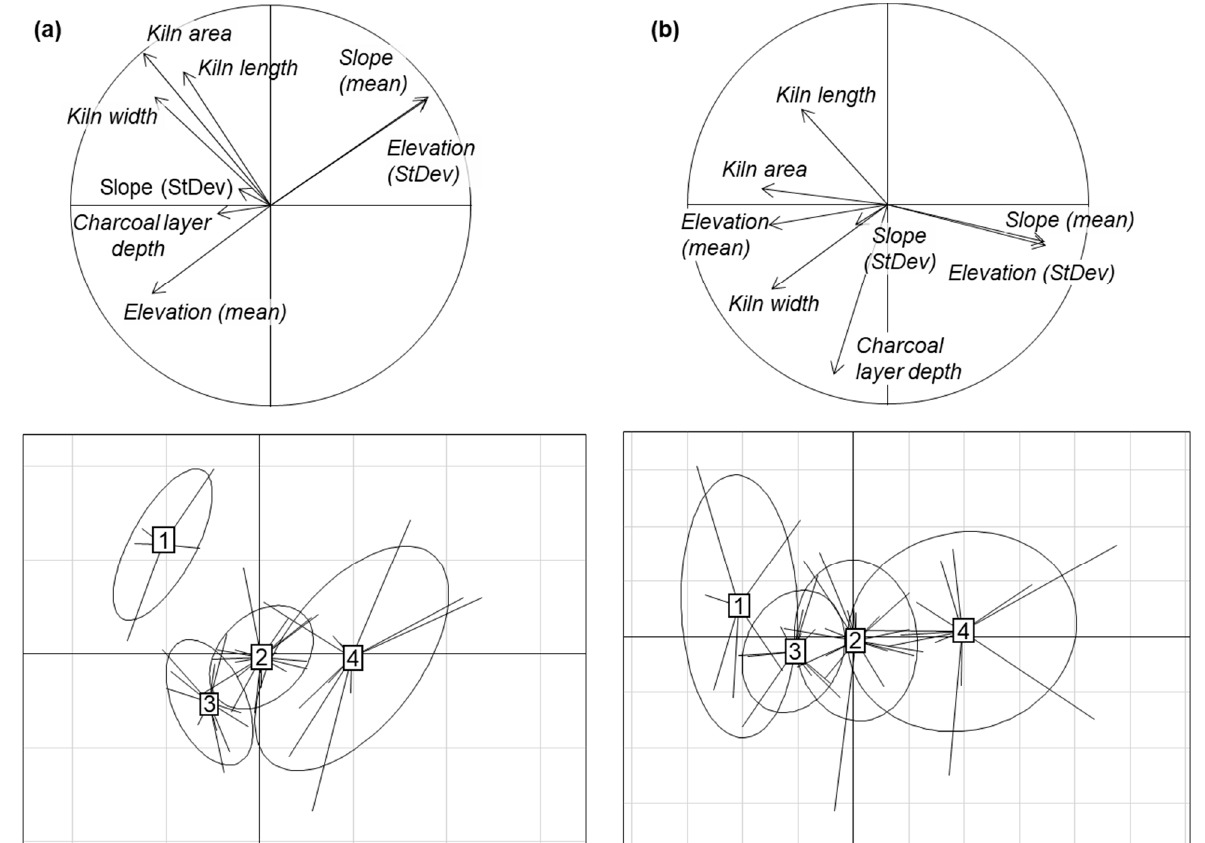
Figure 3. ( a ) Correlation circle ( top ) and individual factorial planes of the PCA on the kiln x socio- environmental/morphometry table, for the axis 1 and 2 and the four groups obtained through hier- archical clustering ( bottom ). ( b ) Correlation circle ( top ) and individual factorial planes of the PCA on the kiln x socio-environmental/morphometry table, for the axis 1 and 3 and the groups obtained through hierarchical clustering ( bottom ). Ellipses represent 95% confidence intervals.